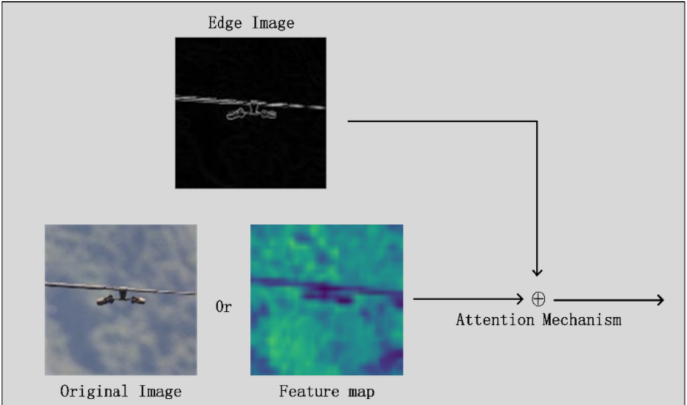
Figure 2. Schematic diagram of the attention